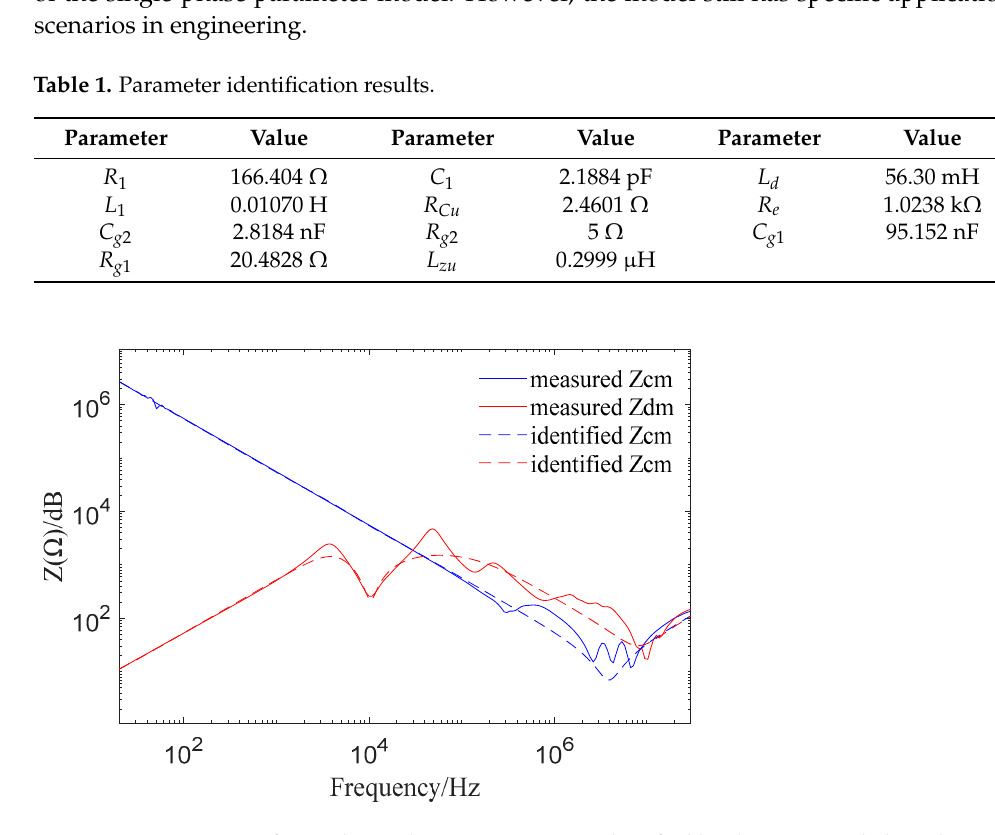
Figure 7. Comparison of impedance characteristic curve identified by the optimized algorithm and state space with actual impedance characteristic curve (20 Hz–30 MHz). state space with actual impedance characteristic curve (20 Hz–30